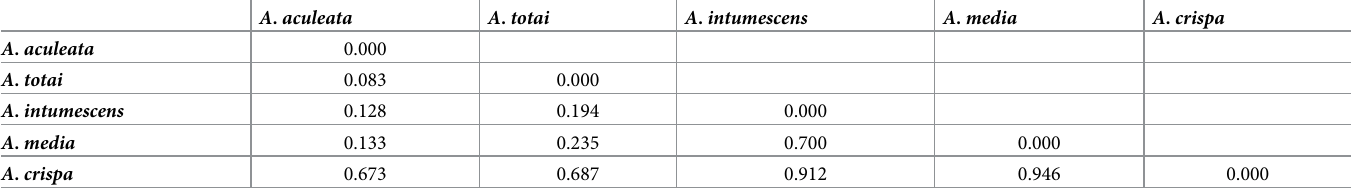
Fig 3. Neighbor-joining [60] tree and principal components analysis (PCoA) of Acrocomia species. a) Scatterplot of the principal components analysis (PCoA) showing the dispersion of samples across the first two principal components and b) Neighbor-Joining dendrogram based on Nei´s genetic distance. Bootstrap support of nodes is shown. https://doi.org/10.1371/journal.pone.0241025.g003 from 0.106 in A . totai to 0.005 in A . media . However, A . crispa was the species with the highest allelic richness (2.29) and the highest allelic richness of private alleles (0.17), while A . media presented the lowest values of allelic richness and allelic richness of private alleles (1.08 and 0.01, respectively). The inbreeding coefficient (F) values were high for all species, indicating Table 1. Pairwise F ST estimates among five species of